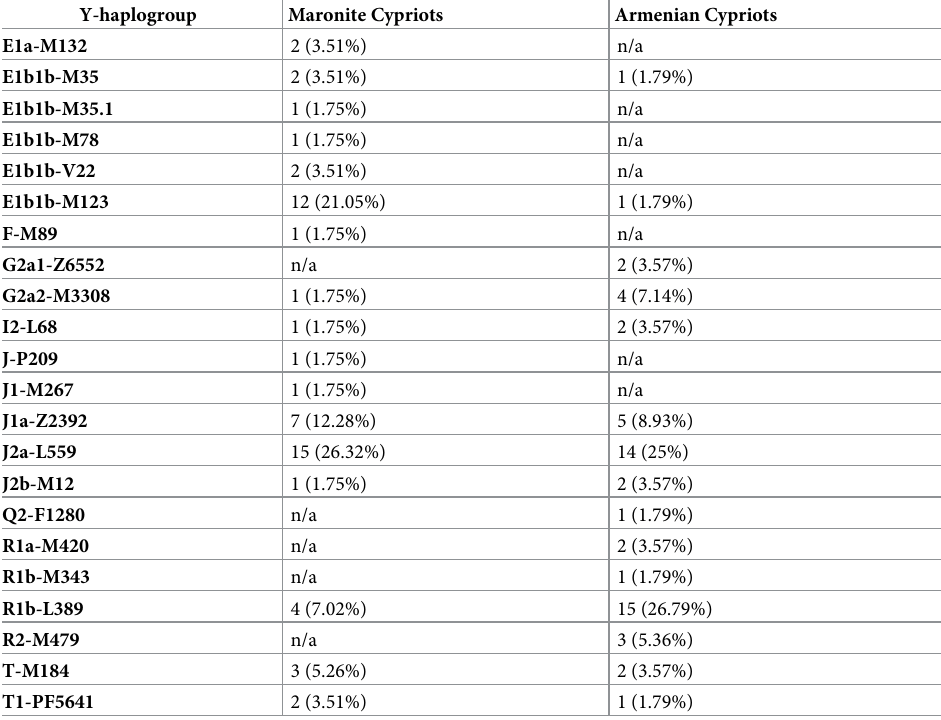
Table 5. Number and percentage of Y-haplogroups and subclades in each population group.